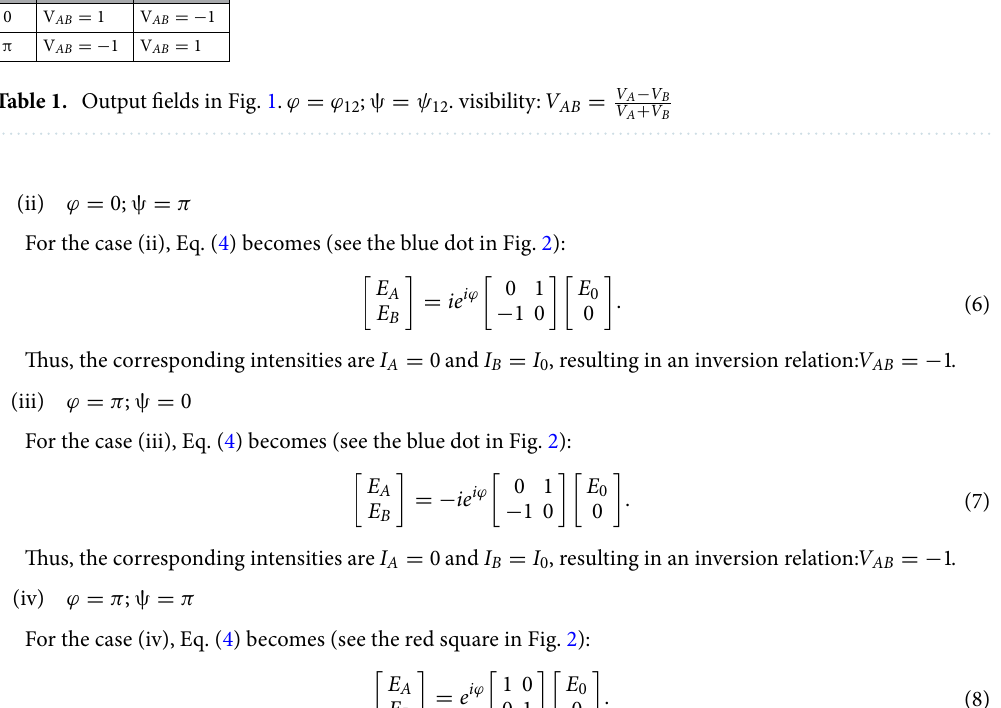
ψ 12 . visibility: V AB =